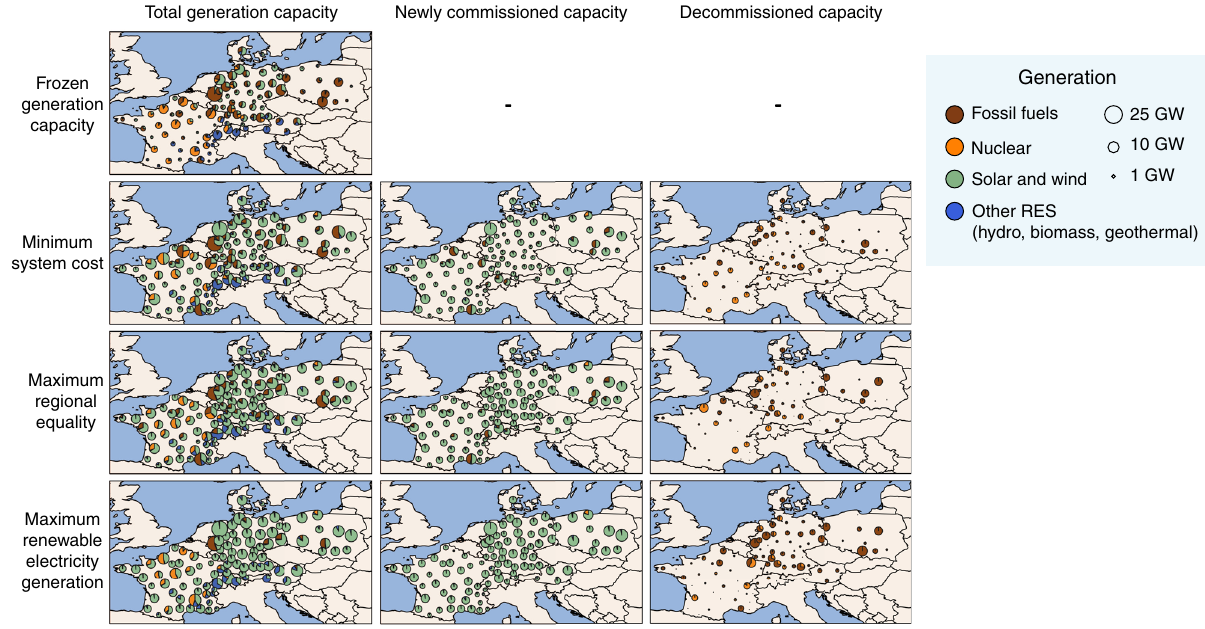
Fig. 2 Regional differences in electricity generation capacity in 2035. The fi gure depicts total, newly commissioned, and decommissioned electricity generation capacity as compared to 2018 at each of the 100 grid nodes for the four distinct scenarios of frozen generation capacity, minimum system costs, maximum regional equality of system costs, and maximum renewable electricity generation. In the scenarios of minimum system costs, maximum regional equality of system costs, and maximum renewable electricity generation, each country meets its national electricity generation targets for 2035 (see “ Methods ” ). Generation capacities are aggregated to the four categories for visualization purposes. Fossil fuels category includes gas, hard coal, lignite, and oil. Solar and wind category includes onshore wind, offshore wind, rooftop solar PV, and open- fi eld solar PV. Other renewable energy sources (RES) category includes hydropower (including large dams, large run-of-river, and small hydropower), biomass (including biogas, biomass waste, and woody biomass), and geothermal